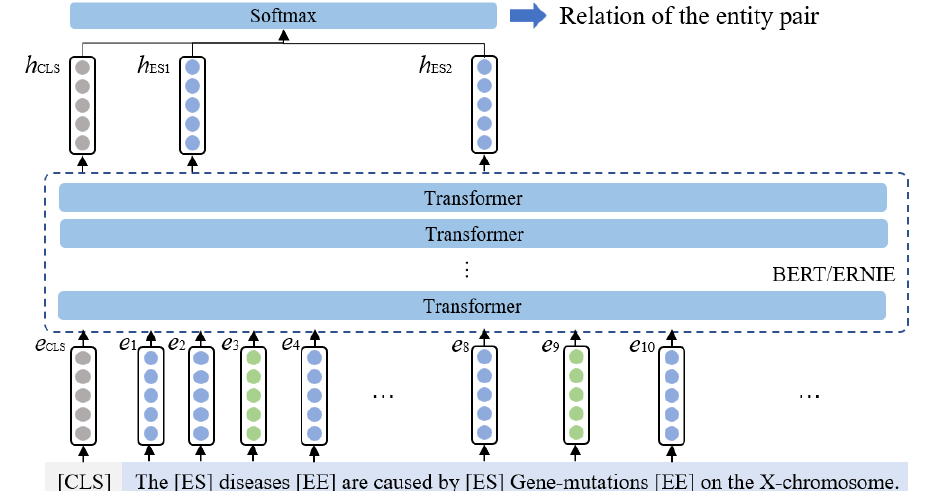
Figure 5. The relation label is generated based on the representations of sequential